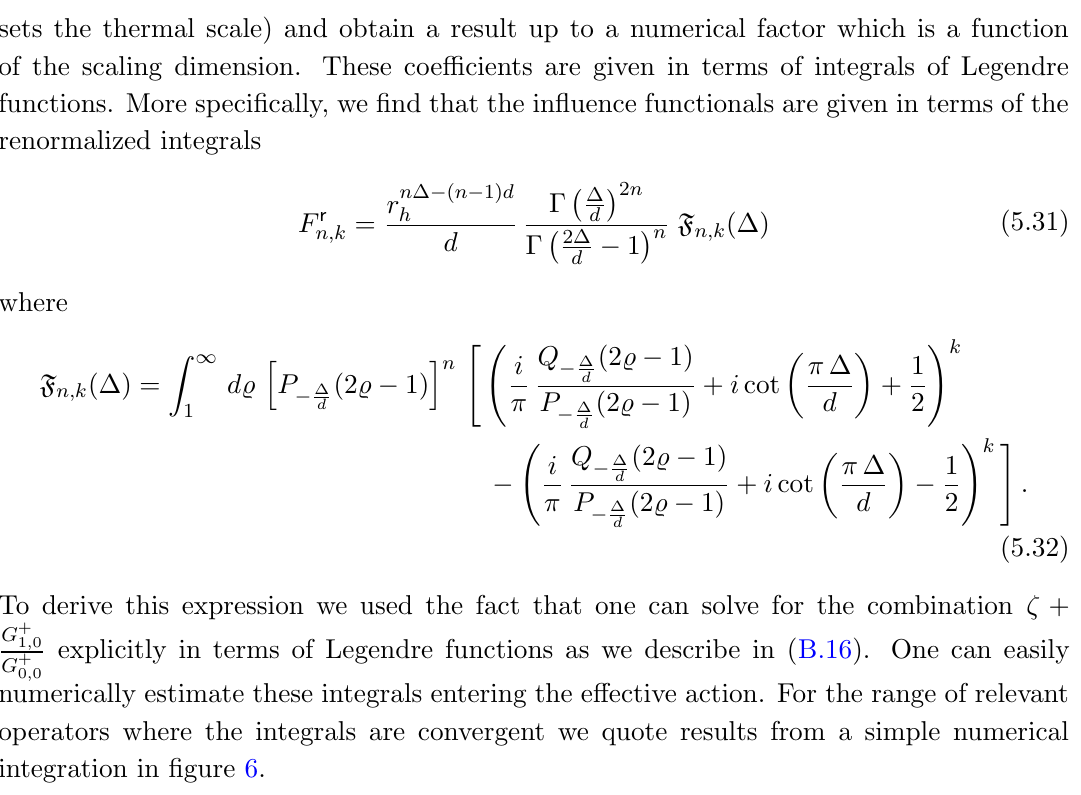
Figure 6 . The numerical values of the quantities F 3 ;k and F 4 ;k as a function of the conformal di- mension (cid:1) (normalized by dimension). We have con(cid:12)ned attention to the case of relevant operators (cid:1) 2 ( d ; n (cid:0) 1 d ) when the integrals are convergent without need of additional counterterms. We note 2 n that F n; 2 k are purely imaginary and F n; 2 k +1 are real | we have thus plotted just the imaginary or real parts in the corresponding